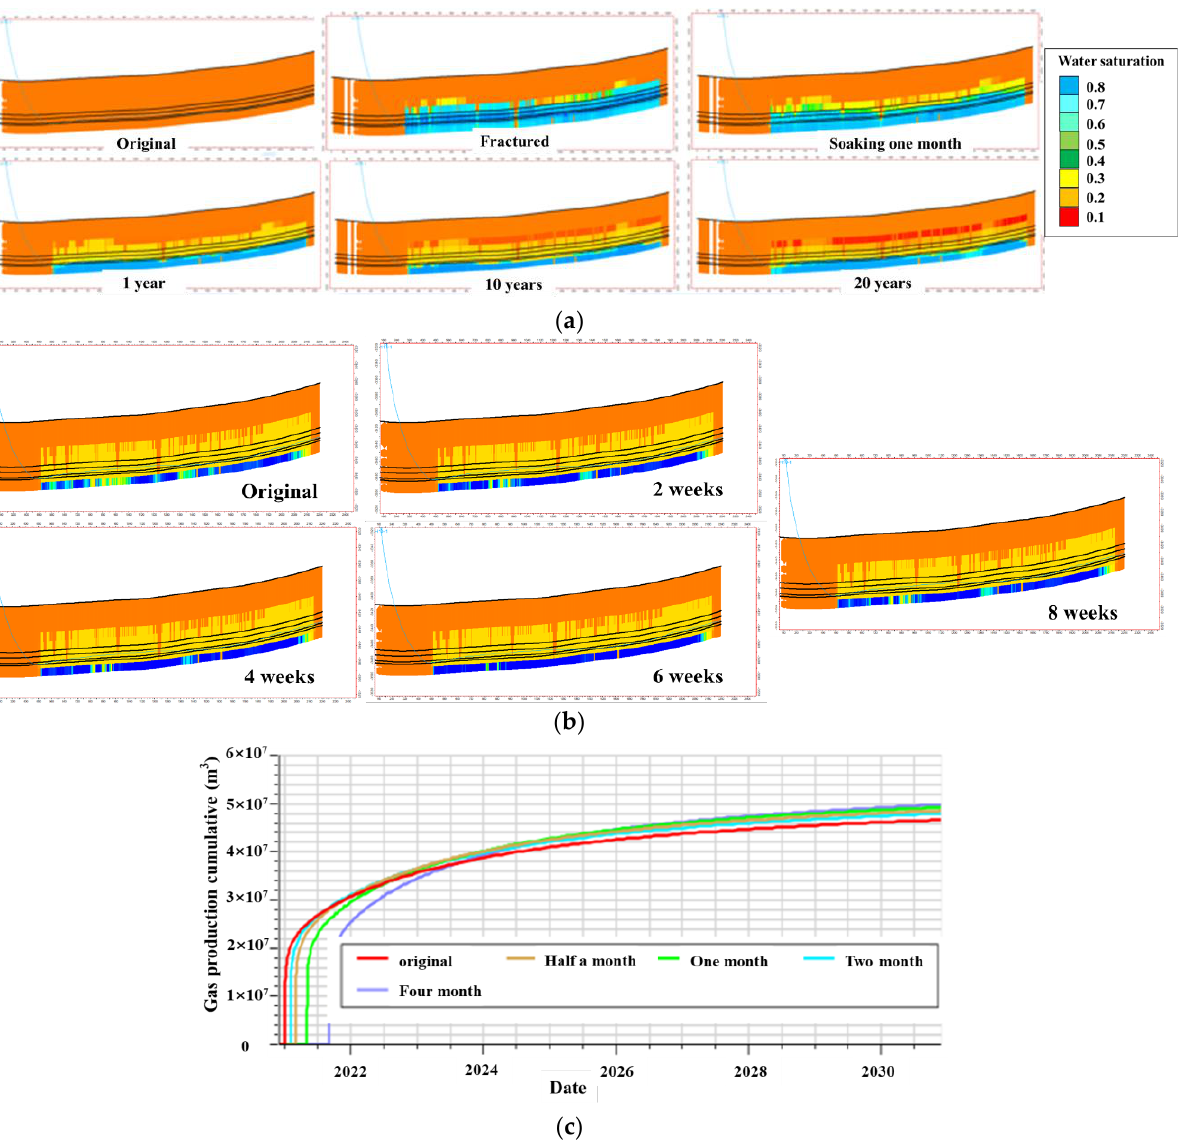
Figure 16. The change in water saturation and EUR in different production periods and soaking times: ( a ) the change in water saturation with a different production period; ( b ) the change in water saturation with a different soaking time; ( c ) the change of EUR with a different soaking time.